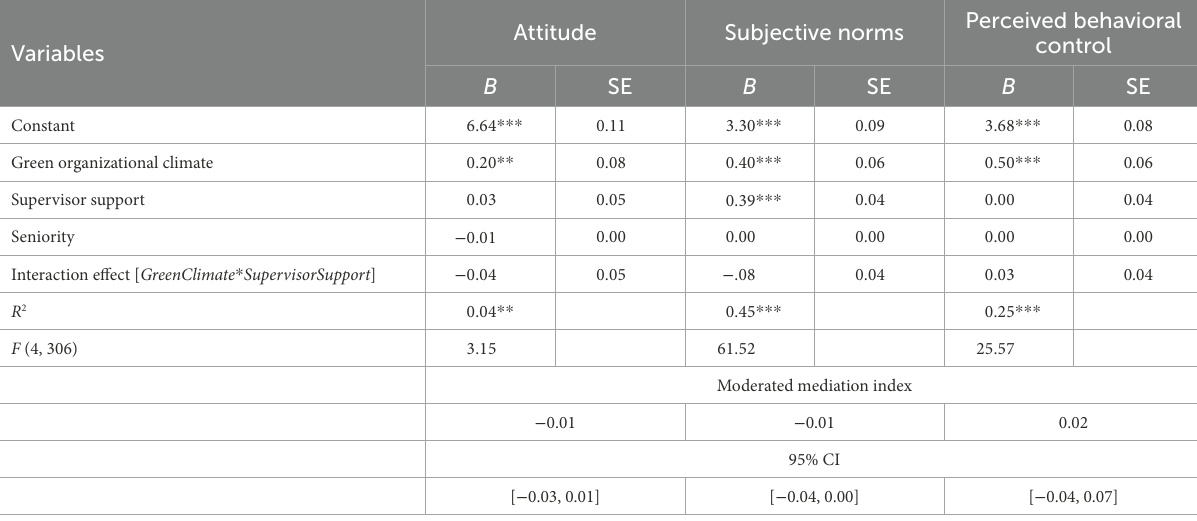
TABLE 6 Moderation and mediated moderation for paper